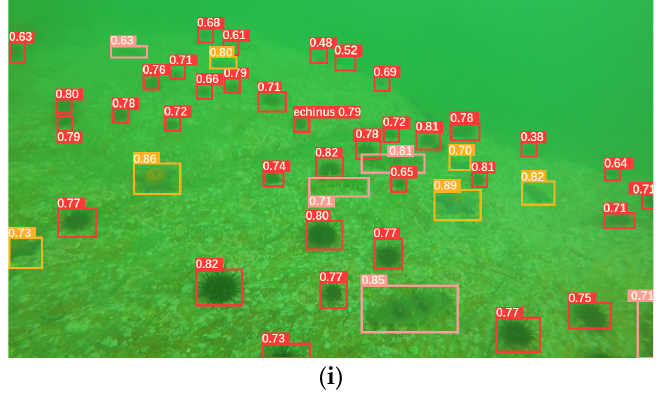
Figure 21. The typical detection results on the test set of the detection performance comparison: ( a ) ground truth; ( b ) detection results of the model proposed by Zhang et al. in [38]; ( c ) detection results of EDR-D0 modal proposed by Jia et al. in [39]; ( d ) detection results of SSD; ( e ) detection results of YOLOv3; ( f ) detection results of YOLOv4; ( g ) detection results of YOLOv5; ( h ) detection results of the proposed model; and ( i ) detection results of the proposed framework. In ( b – i ), the red, orange and pink boxes represent the echinus, starfish and holothurian, respectively. In ( b – i ), red boxes represent echini, pink boxes represent holothurians and orange boxes represent starfish).